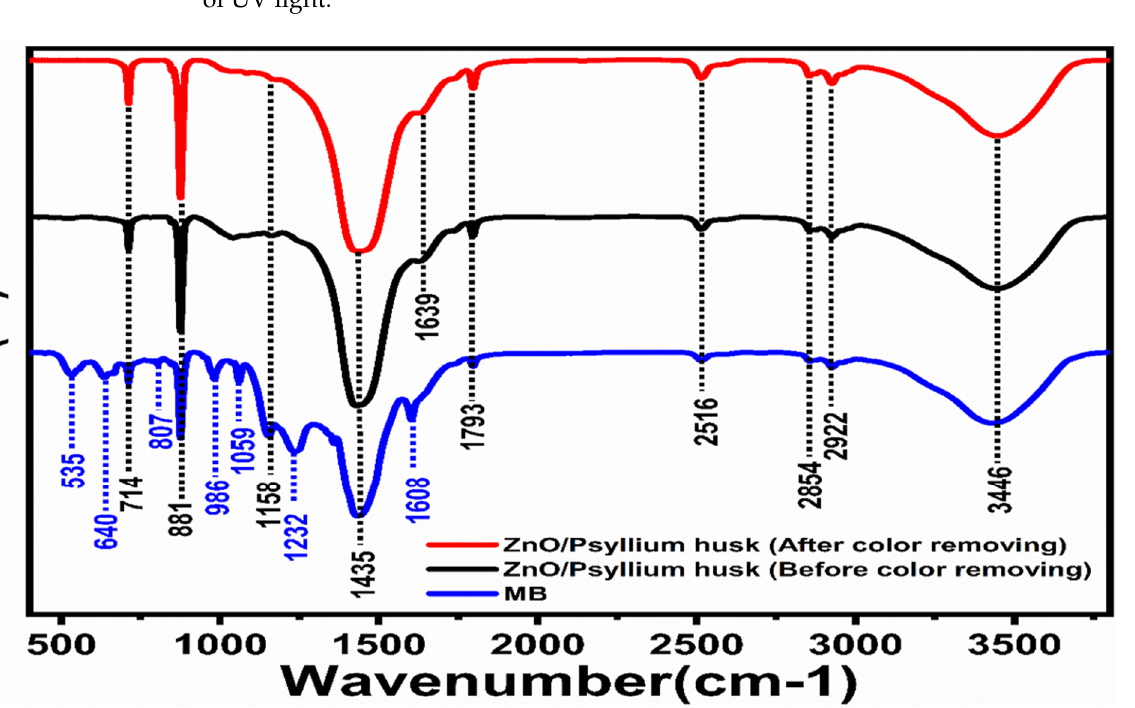
Scheme 1. Shows main chemical constituents of psyllium husk.